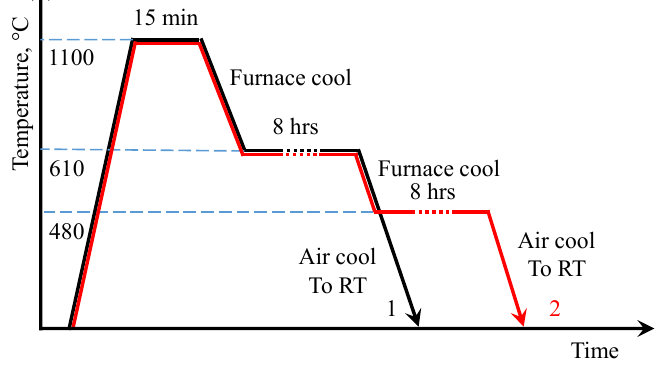
Figure 2. A schematic illustration of the heat treatment procedure.